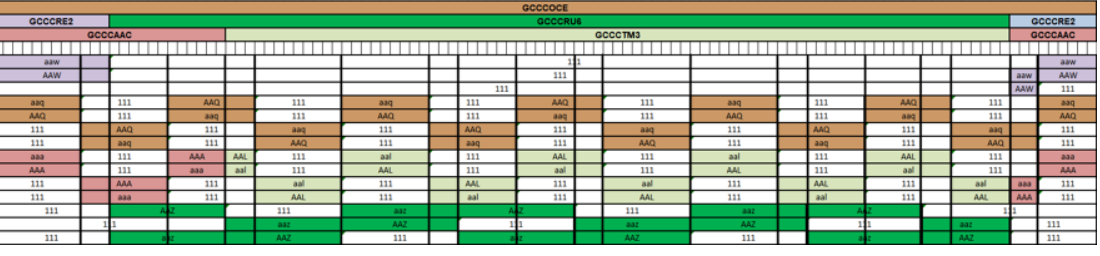
Figure 4. Example of a grid